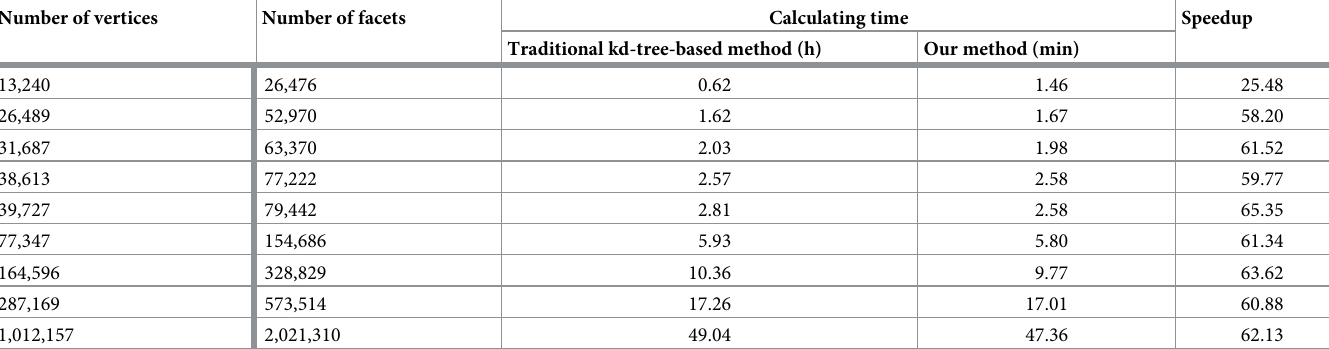
Table 3. The calculating time of monostatic RCS simulations of different objects at f = 10 GHz. Number of